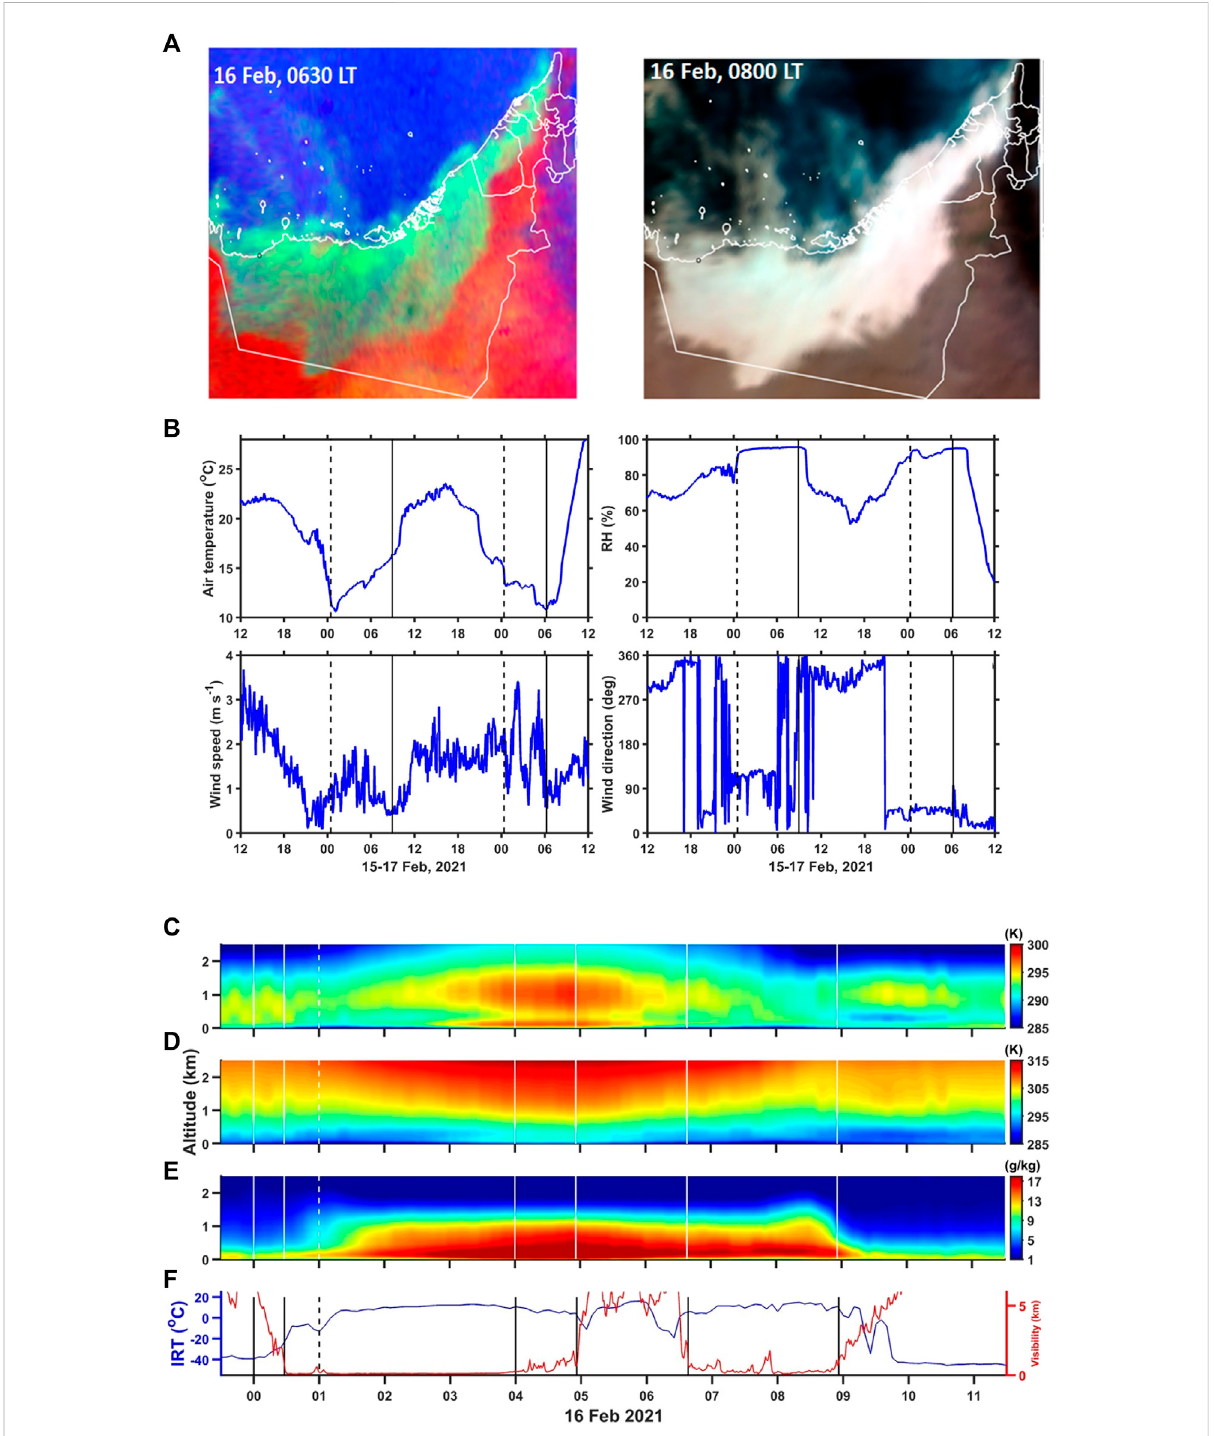
FIGURE 8 (A) SEVIRI Satellite images on 16 February 2021 at 06:30 and 08:00 Local Time (LT) over the UAE. In the nighttime images fog is highlighted in light green while in the daytime images it is shaded in white. (B) Air temperature ( ° C), relative humidity (%) and horizontal wind speed (m s − 1 ) and direction ( ° ) from 12 LT on 15 February to 12 LT on 17 February 2021. The onset and termination of fog is indicated by dashed and solid vertical lines, respectively. (C) Air temperature (K), (D) potential temperature (K) and (E) speci fi c humidity (g kg − 1 ) in the bottom 2.5 km of the atmosphere derived from the MWR measurements on 15 February 2021 between 0 and 11 LT. (F) Brightness temperature (K; blue curve) from the Infrared Temperature Sensor (IRTS) attached to the instrument and visibility estimates from the visiometer (km; red curve) during the same